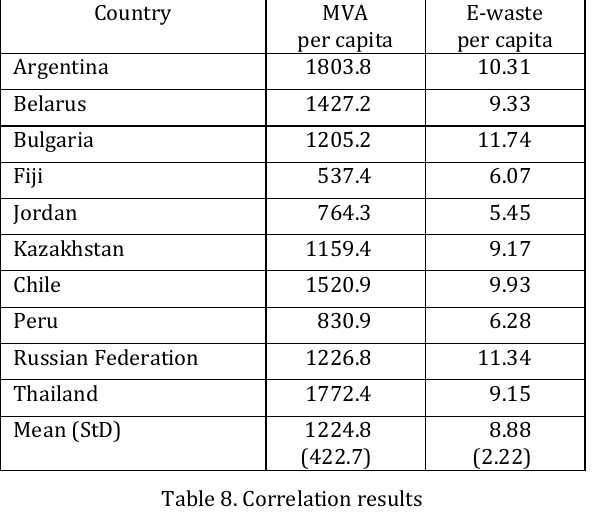
Table 7. Descriptive data (upper-middle-income